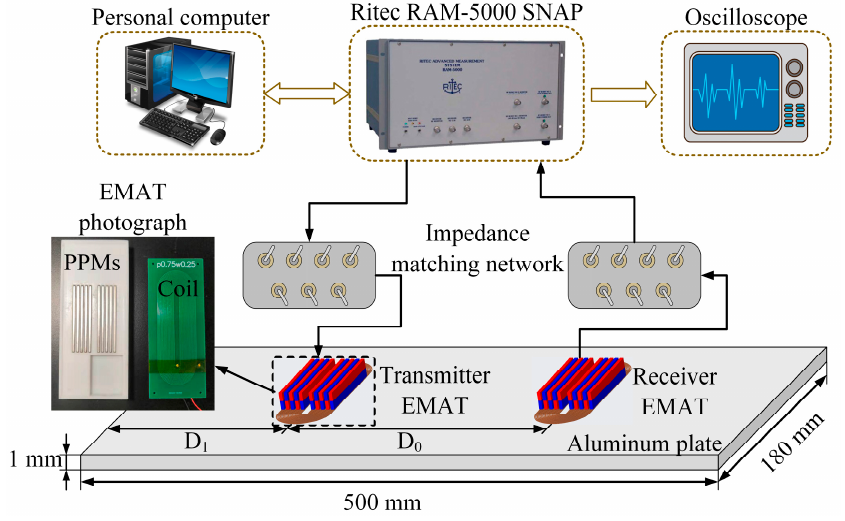
Figure 15. Schematic diagram of the experimental system.